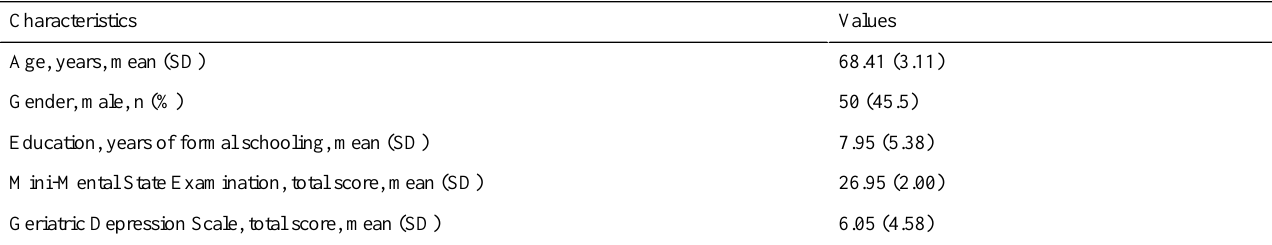
Table 1. Characteristics of the study participants (N=110).